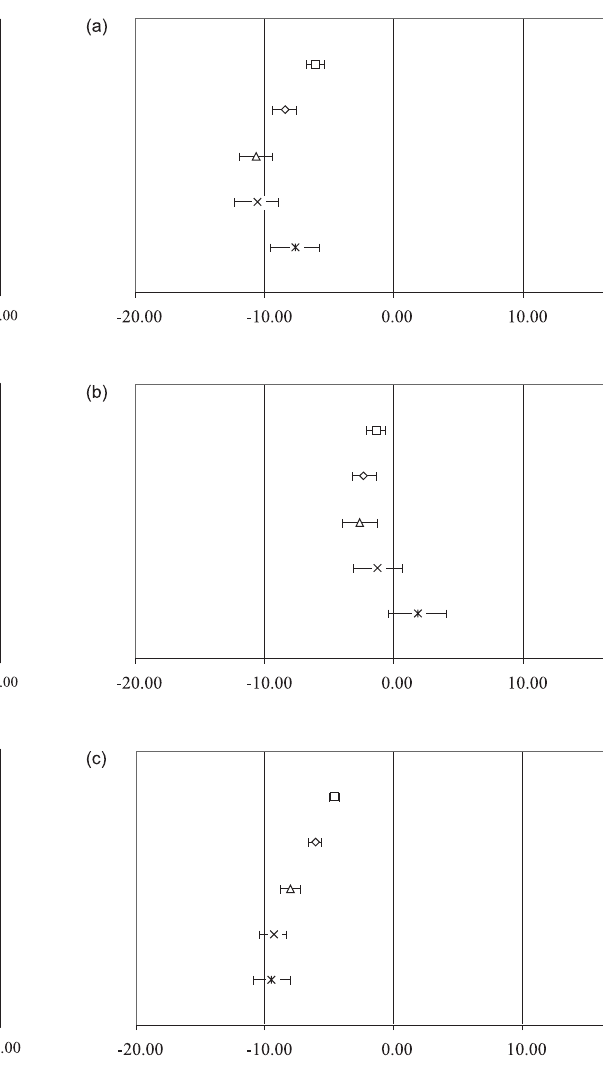
FIGURE 3 - Equivalence test (two one-sided test) for dissolution profiles of 10 mg generic versus 40 mg generic (a), 20 mg generic versus 40 mg generic (b) and 10 mg generic versus 20 mg generic (c). Dissolution time-point of 1 (  ), 2 (  ), 4 (  ), 8 (  ) and 12 hours (  ).